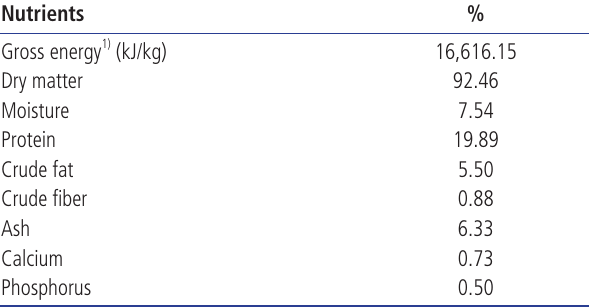
Table 1. The nutrients composition analysis of creep feed used in this study